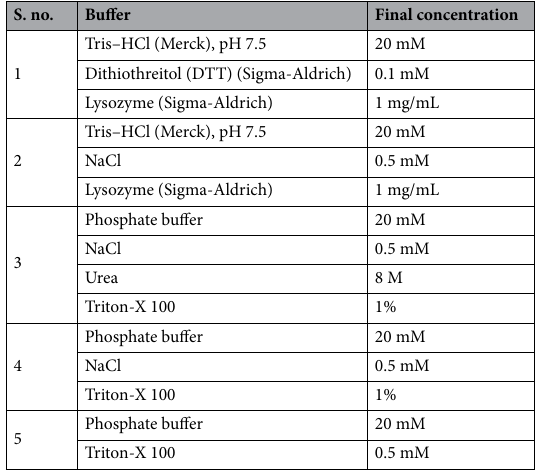
Table 1. Buffers and their composition used in the optimization of expression of recombinant